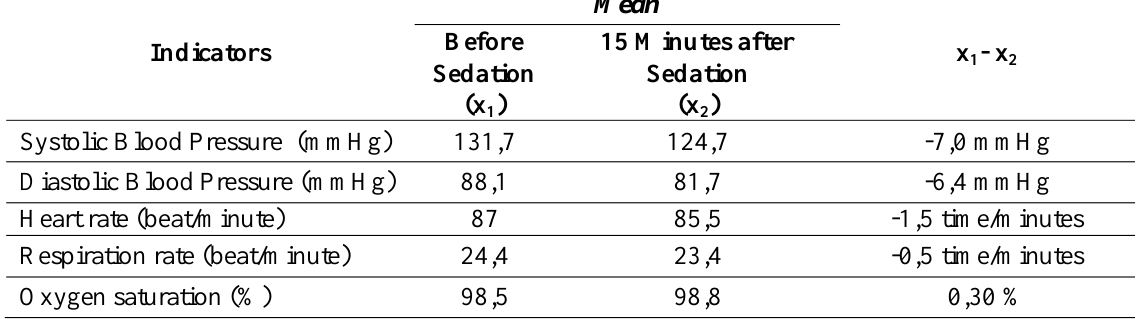
Table 2. Characteristics of Cardiac Workload Respondents